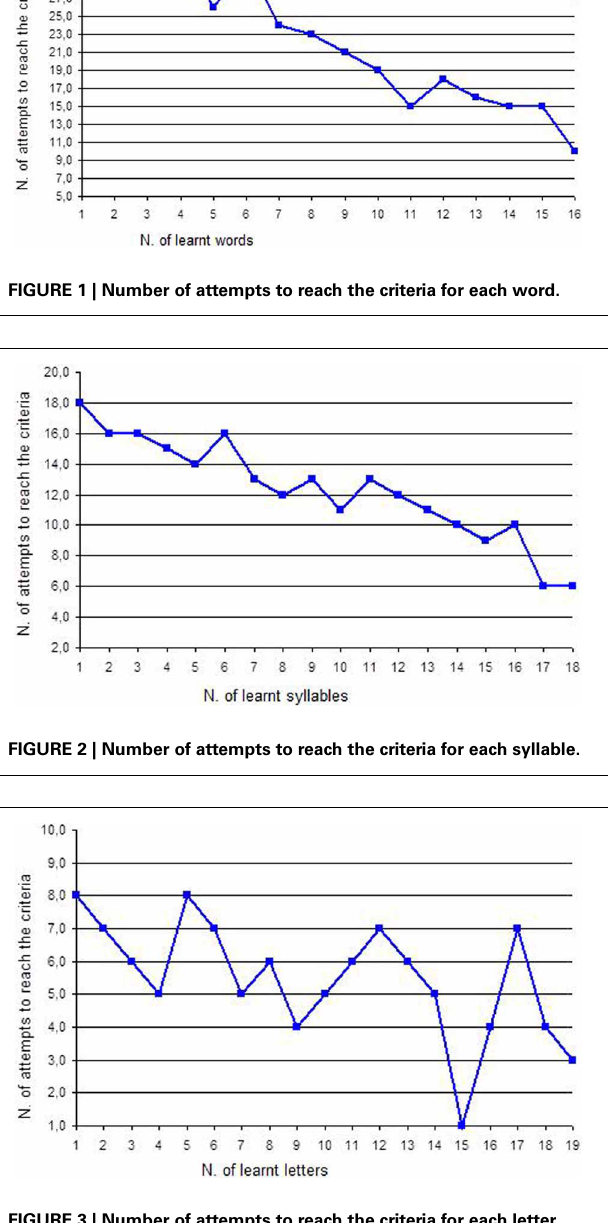
(cid:129) She is given a little help (i.e., her head is kept still so that she can concentrate her gaze and her hand movement): + .